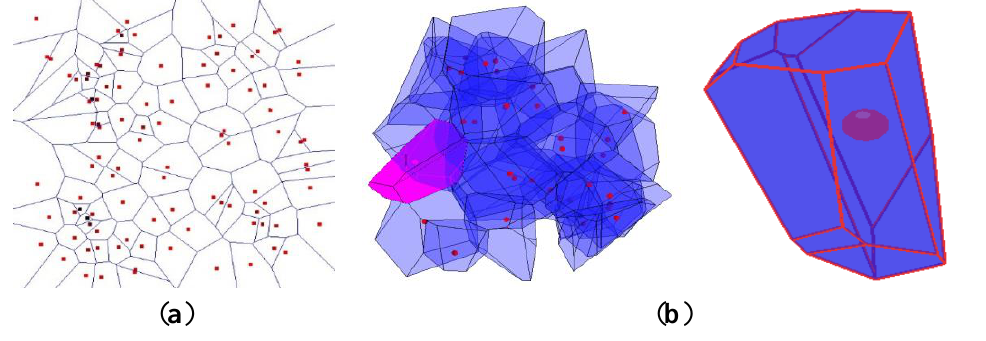
Figure 1. Two-dimensional Voronoi diagram ( a ) and 3D Voronoi diagram/cell ( b